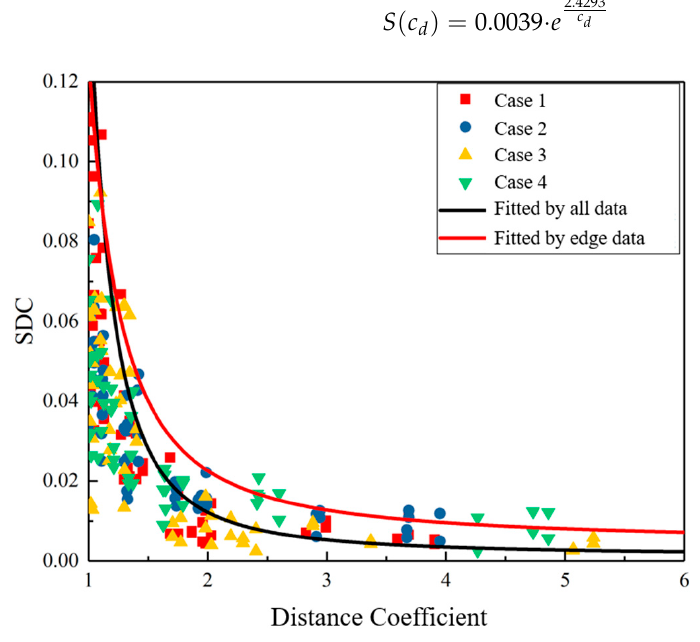
Figure 9. Relationship between distance coefficient and signal difference coefficient.